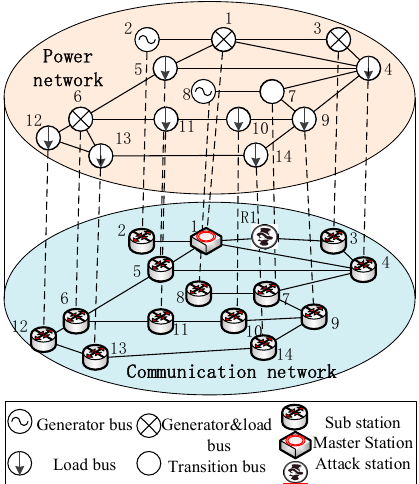
Figure 10. Cyber physical architecture of IEEE 14-bus system.